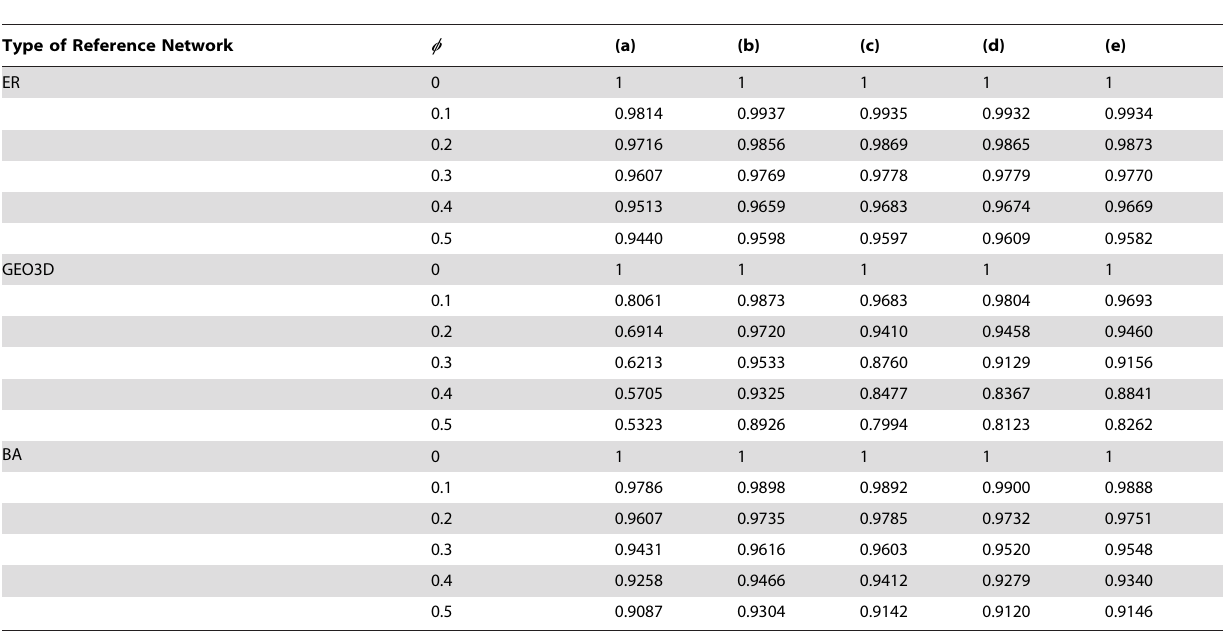
Table 1. This table summarized the EVSA values obtained from a series of control tests.